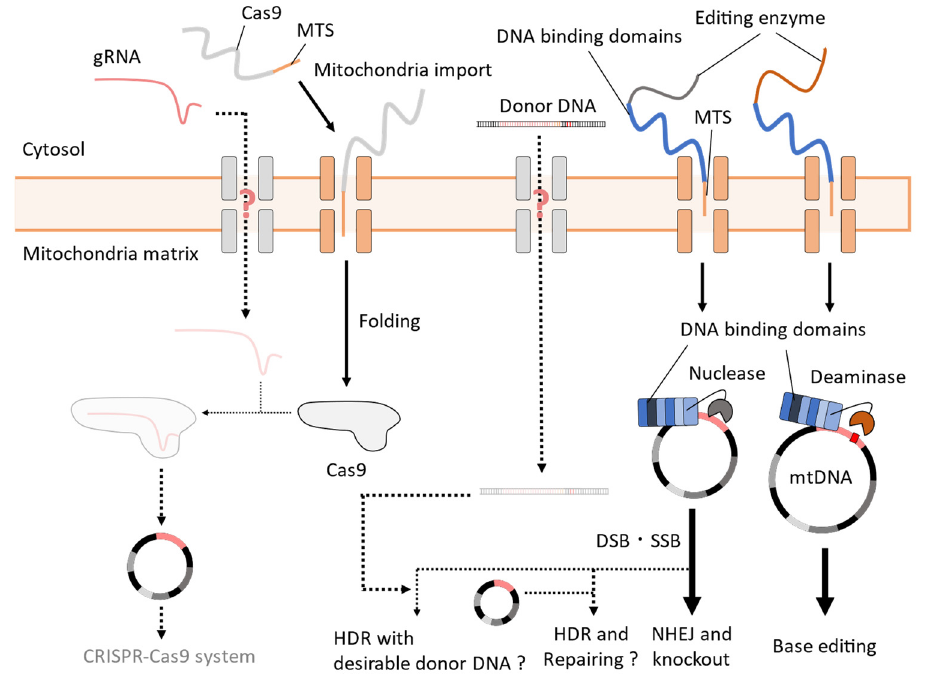
Figure 6. Difficulty in the mitochondrial transportation of elements necessary for mitochondrial genome editing. Any protein can be imported to the mitochondria by fusing with MTS. Thus, base editing can be performed using modular DNA-binding domains and deaminases. However, the native mitochondrial transportation of gRNA and donor DNA is unclear, making it difficult to introduce desirable sequences using the CRISPR-Cas9 system and HDR in mtDNA.